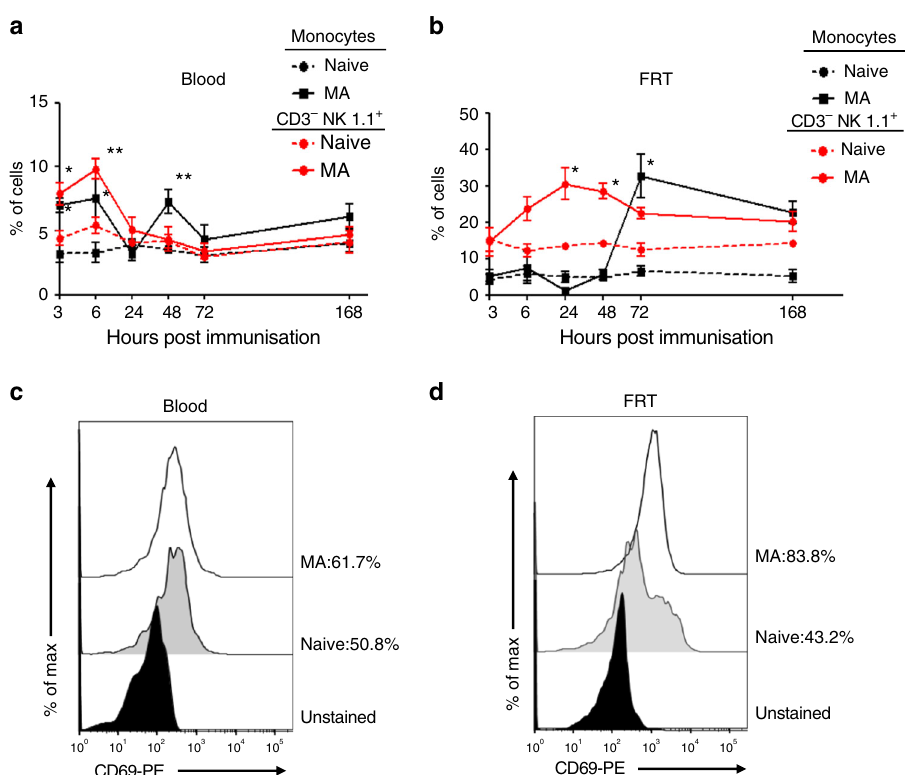
Fig. 6 Skin immunisation promotes the early recruitment of ILC1 and monocytes to the FRT. a , b Frequency of ILC1 (CD45 + NK1.1 + CD3 − ) and monocytes (CD45 + Ly6C + CD11b + MHCII − ) in peripheral blood ( a ) and FRT tissue ( b ) at the indicated time points from naive or Ad-CN54 gag skin MA immunised mice ( c , d ). Representative fl ow-cytometry pro fi le of CD69 expressed on ILC1 isolated from peripheral blood ( c ) or FRT tissue ( d ), 24 h after Ad-CN54 gag immunisation or from naive controls. Data are from three independent experiments ( n = 3 – 10 per group). * p < 0.05, ** p < 0.01 by one-way ANOVA, error bars show